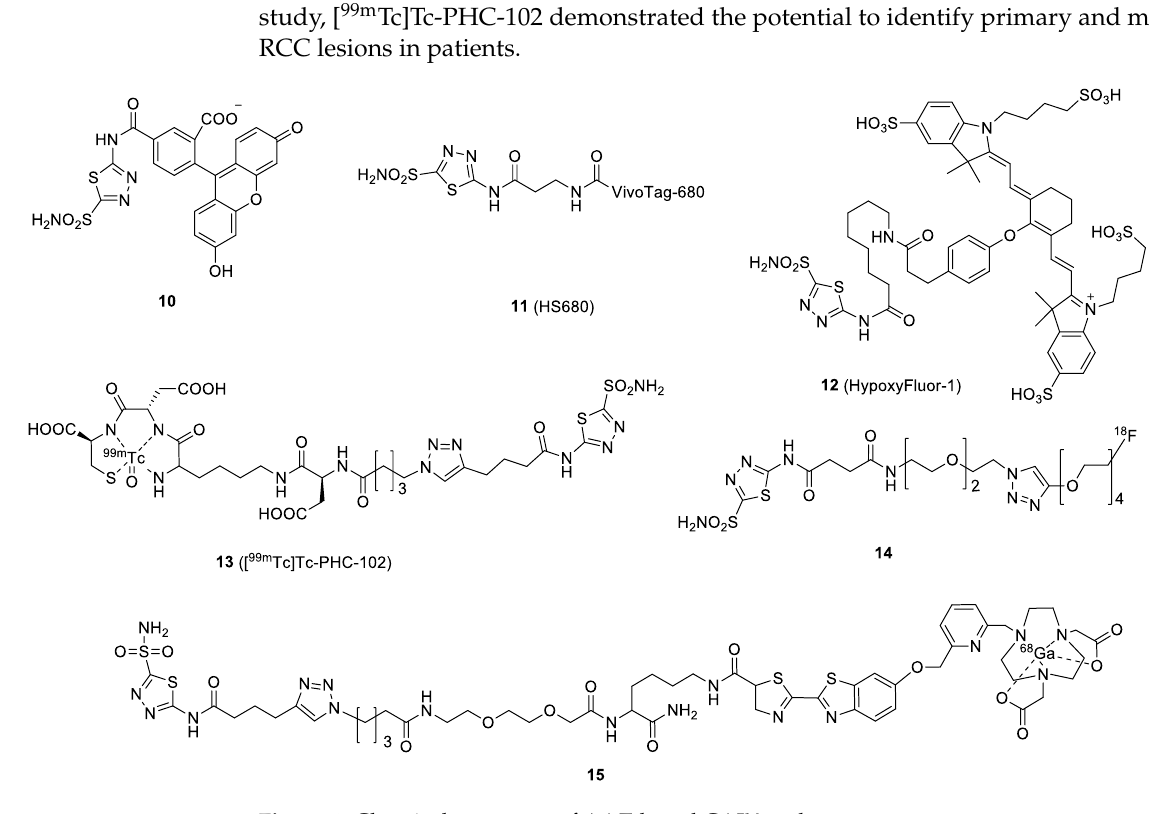
Figure 4. Chemical structures of AAZ-based CAIX probes.